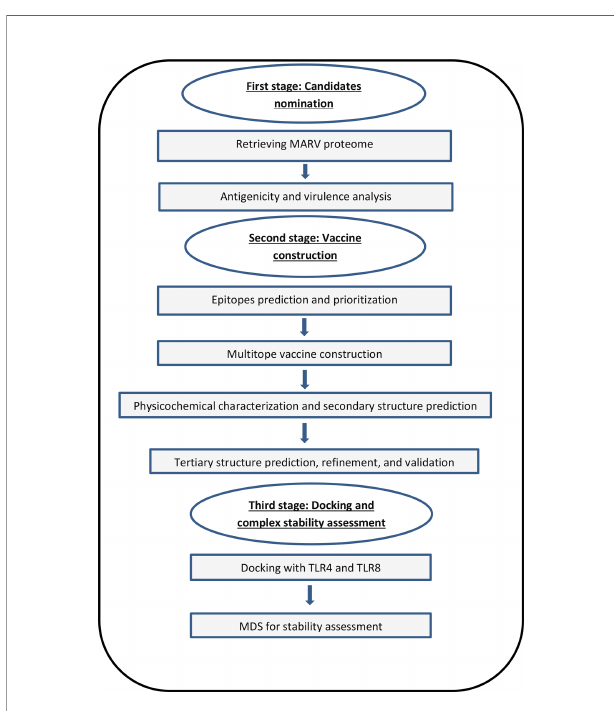
FIGURE 1 | A graph showing the applied strategy of the current study for designing and assessment of a potential vaccine against